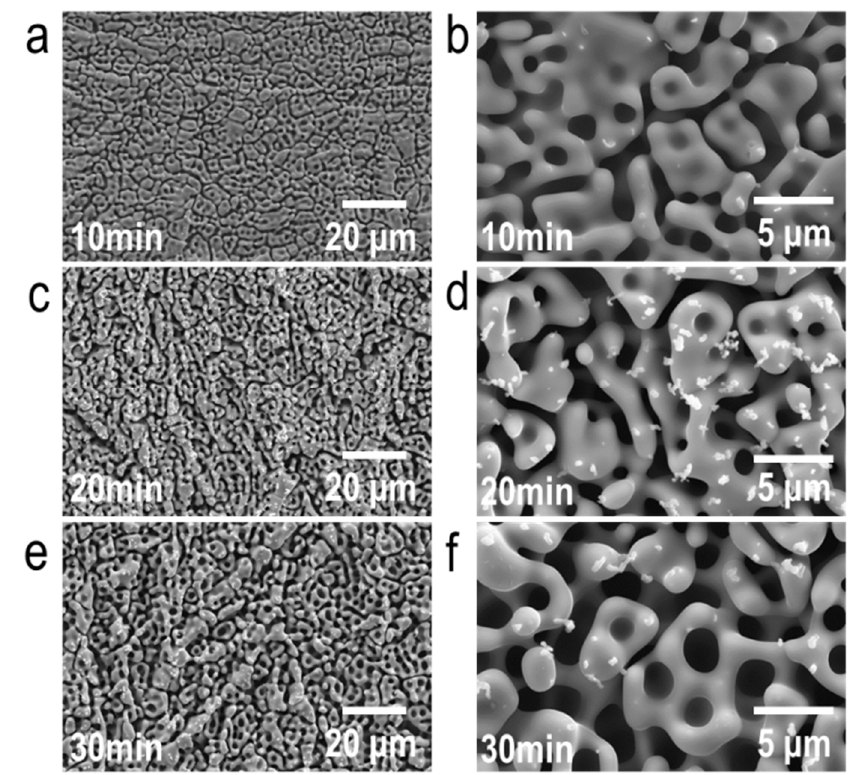
Figure 4. Scanning electron micrographs of the surface of Ti-6Al-7Nb dealloyed in liquid Mg at 1150 K for different time spans: ( a , b ) 10 min, ( c , d ) 20 min, and ( e , f ) 30 min. Note: The white spots in micrographs ( d ) and ( f ) are contamination particles.